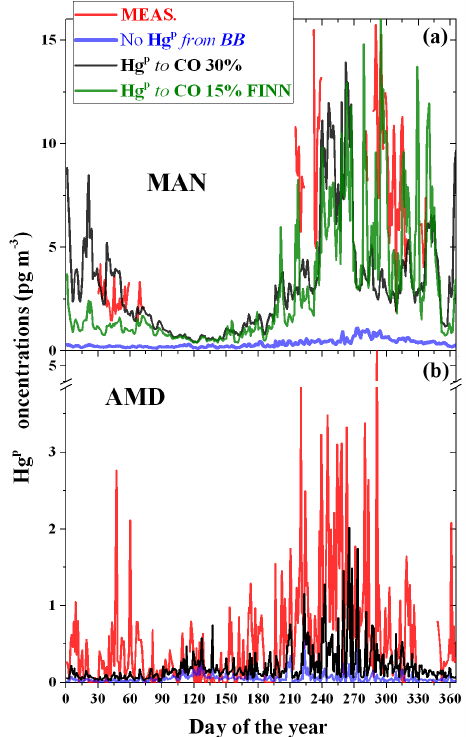
Figure 10. Temporal evolution of daily averaged surface Hg P con- centrations measured at Manaus (MAN) and Amsterdam Island (AMD) for the entire 2013, compared with a selection of sensitivity runs.